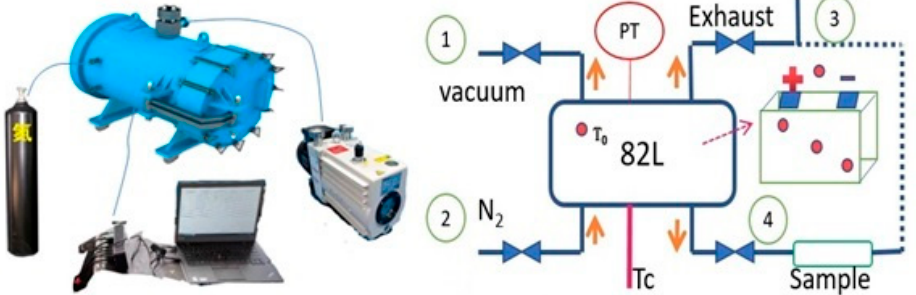
Figure 1. The main component of the experimental apparatus and its principal elements. It consists of the experimental equipment, monitor, vacuum pump, and nitrogen gas cylinder.